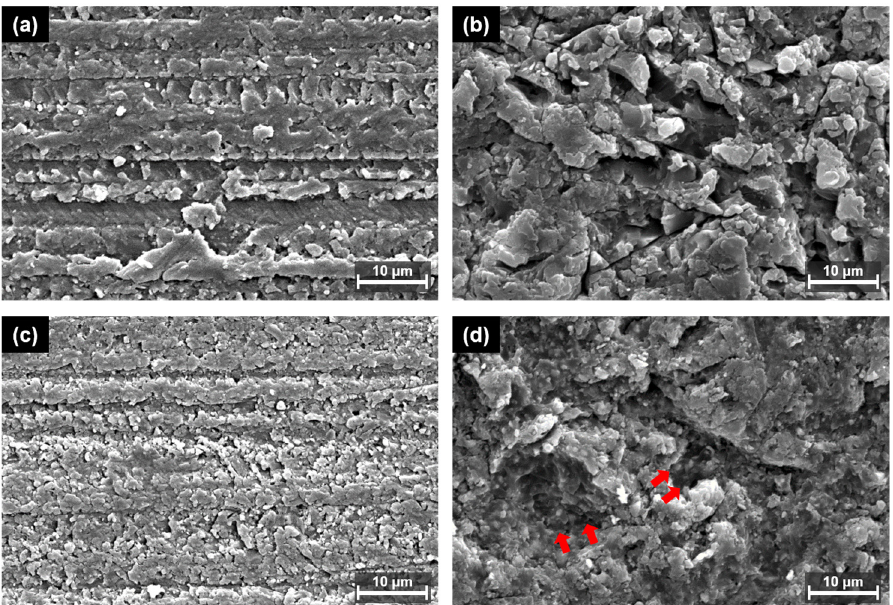
Figure 7. High-magnification (×2000) SEM images of both types of 3D printing resins for different surface treatments: ( a ) No surface treatment of Group 1; ( b ) APA of Group 1; ( c ) no surface treatment of Group 2; and ( d ) APA of Group 2. The red arrows indicate the deep, and wide porous surface.